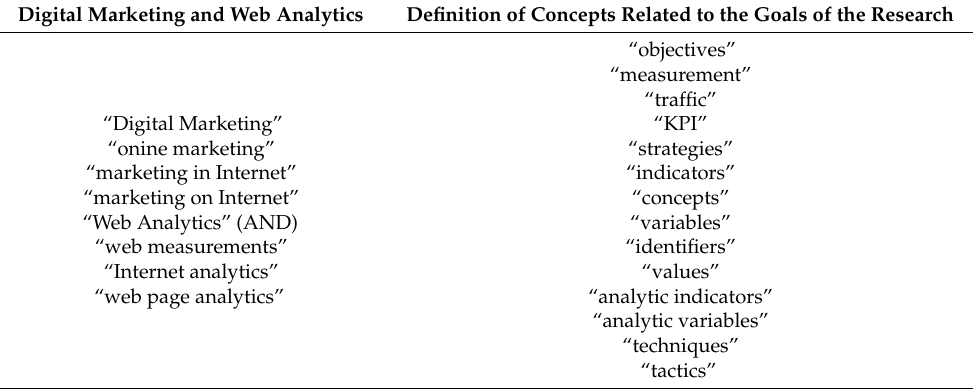
Table 1. Search term used. Table 1 . Search term used .